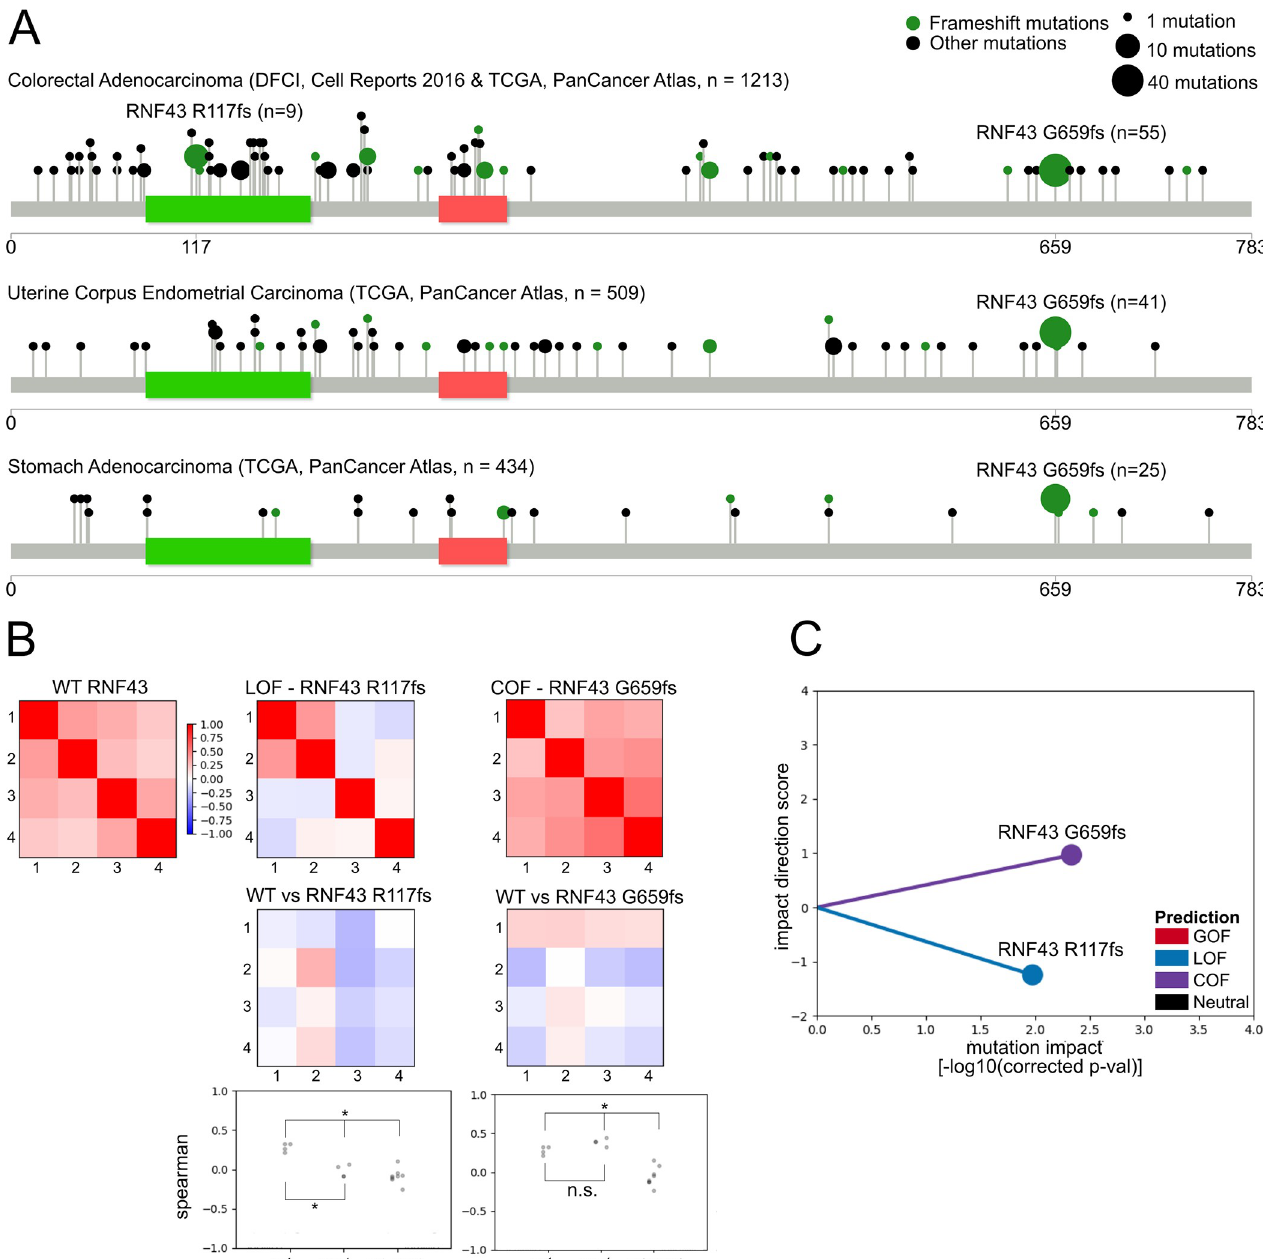
Fig 2. eVIP identifies functional differences between two RNF43 frameshift mutations. (A) Lollipop plots [20] showing the frequency of mutations in RNF43 in three different cohorts[21,22]. The ZNRF-3 ectodomain is indicated in green and the ring finger domain is indicated in red. (B) Heat map representation of WT replicate consistency (WT vs WT) or variant replicate consistency (RNF43 G659fs vs RNF43 G659fs and RNF43 R117fs vs RNF43 R117fs). Values correspond to Spearman rank correlation. Signature identity (WT vs variant) is represented by heatmaps in the second row. Dot-plot representation of replicate consistency and signature identity measured by Spearman rank correlation. � , adjusted p < 0.1. n.s., adjusted p > 0.1. (C) A “sparkler” plot representation of eVIP predictions[7]. A point represents a variant. The x-axis represents the Kruskal Wallis “impact test” -log10(adjusted p- value). The y-axis is the “impact direction score”, the absolute value of which is equal to the–log10 (adjusted p-value) of a Wilcoxon test directly comparing wild-type and mutant ORF replicate consistency. The sign of the impact direction score is positive if the mutant replicate consistency is greater than WT and negative if the mutant replicate consistency is less than the WT replicate